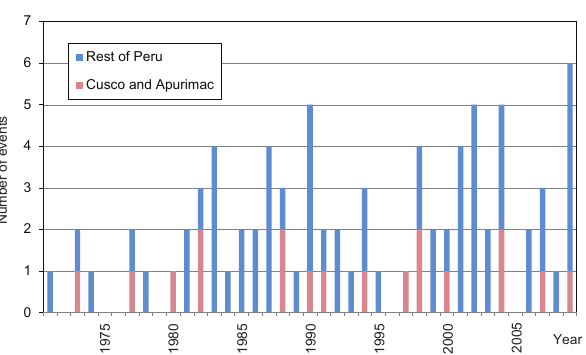
Figure 6. Number of climatic disasters in Peru from 1971 to 2009, based on EM-DAT. Events reported for Cusco and Apurímac are